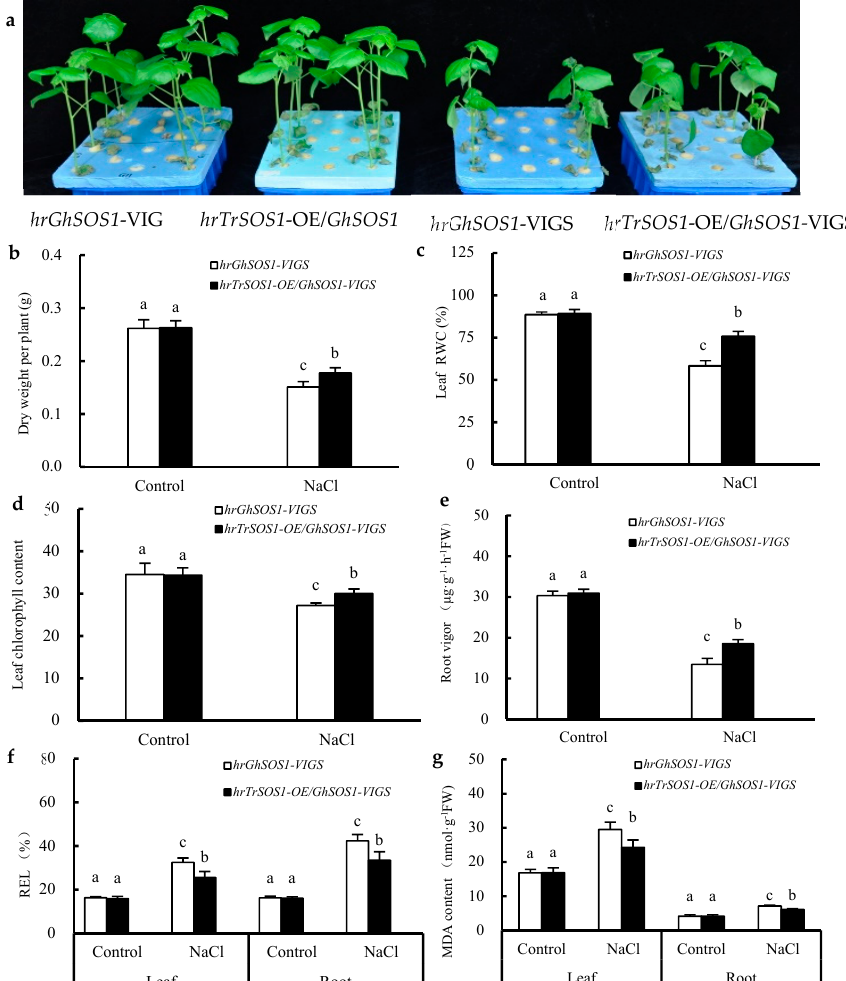
Figure 3. Effects of salt treatment on growth phenotype ( a ), dry weight per plant ( b ), leaf relative water content (RWC) ( c ), leaf chlorophyll content ( d ), root vigor ( e ), REL ( f ), and MDA content ( g ) in the leaves and roots of hairy root composite cotton plants of hrGhSOS1 -VIGS or hrTrSOS1 -OE/ GhSOS1 -VIGS. Different lowercases in the same group indicate the significant differences ( p ≤ 0.05).